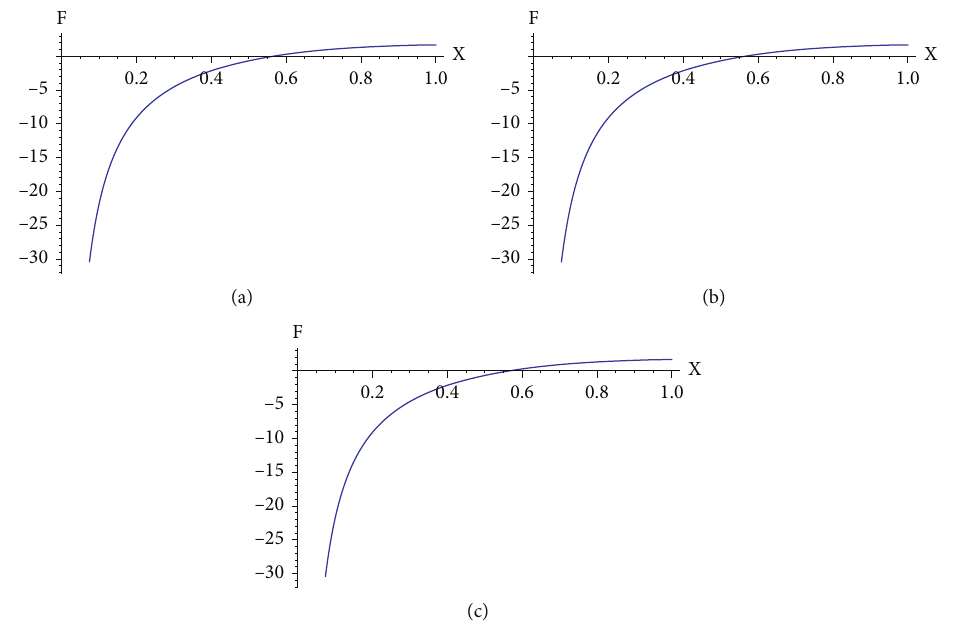
Figure 7: (color online). F − x curves with l 2 = 100 , and (a) for ϕ 2